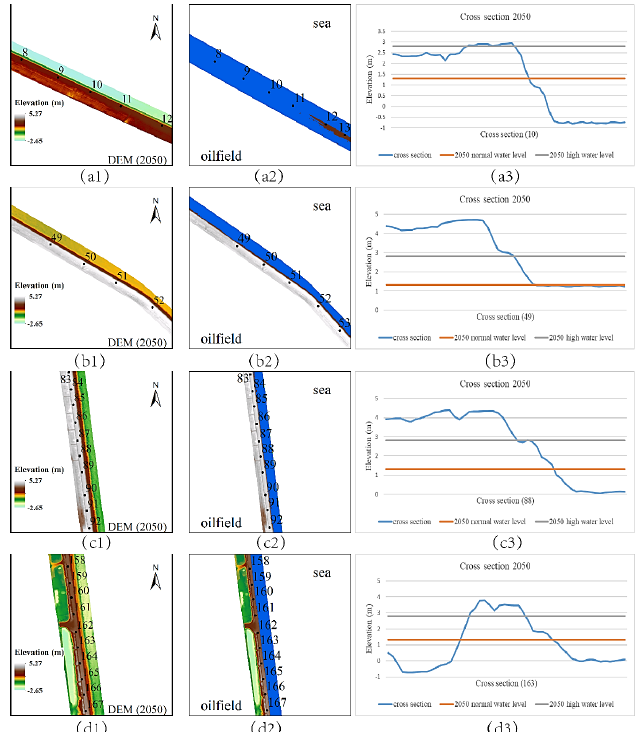
Figure 29. Cross section of the dam and 2D inundation diagram for 2050. The first column shows the DEM of four different parts of the dam in 2050, and the second column indicates the inundation range of the dam due to the highest sea-level (2.81 m) shaded in blue. The third column represents a cross section of the dam at points 10, 49, 88 and 163, in which the right direction is seaward. The intrusion point was found in the section of point 10.